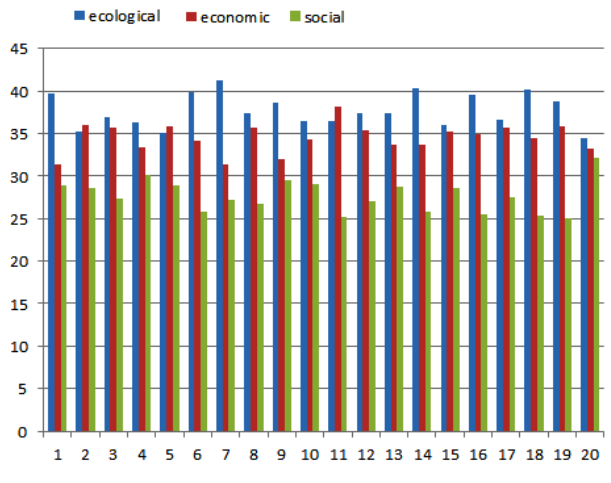
Fig. 7 . Average committee score on the pillars for 20 randomly drawn Regional Advisory Council (RAC) executive committees with 8 industry representatives and 4 NGO